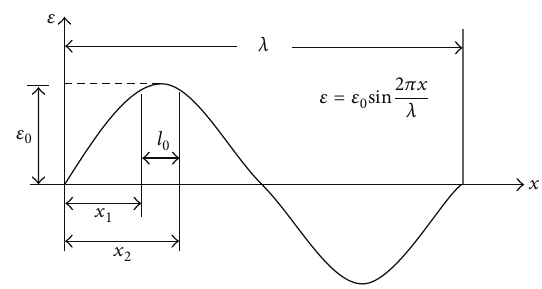
Figure 1: The response property of FBG strain sensor to sine strain